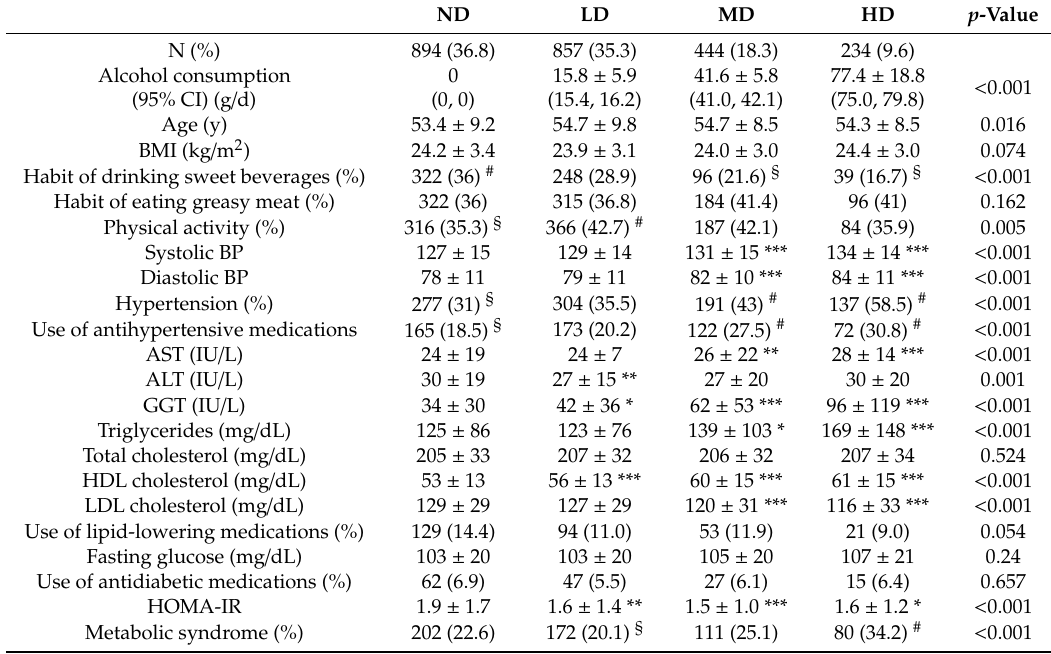
Table 1. Clinical characteristics according to categories of consumption of alcohol.